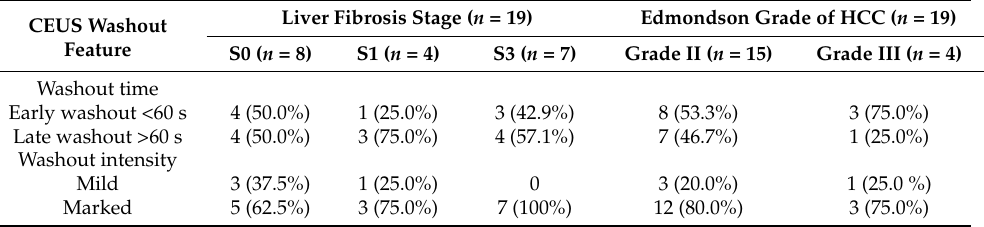
Table 4. Rate of early washout according to liver fibrosis stage and HCC tumors’ histopathologic grades in the non-cirrhosis